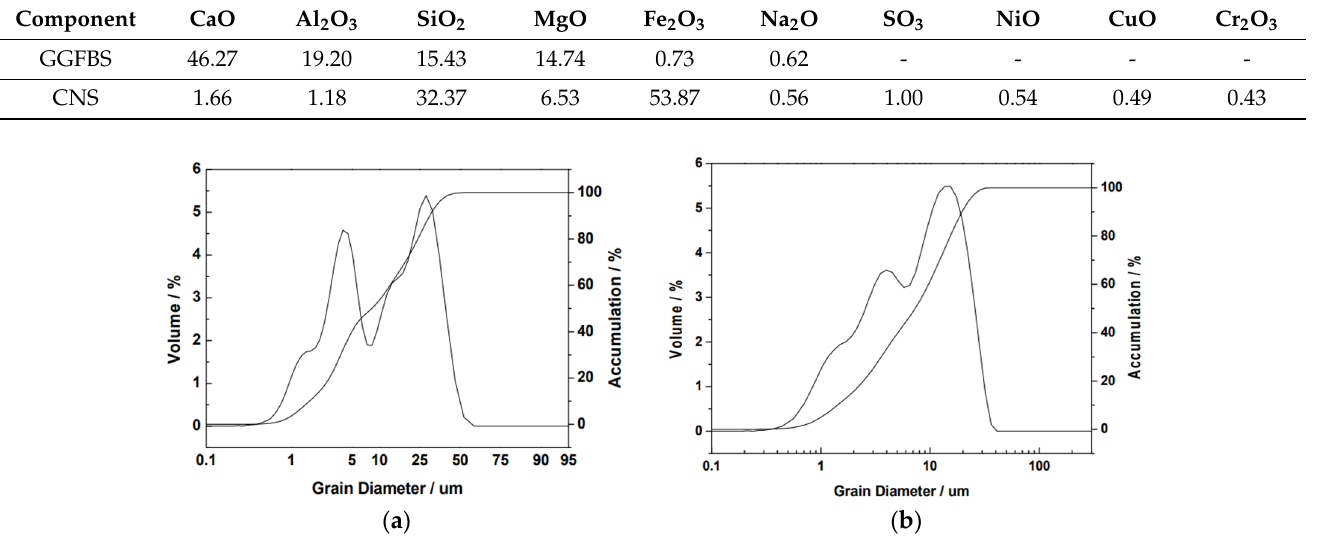
Figure 1. Particle size distribution of raw materials ( a ) CNS, ( b )